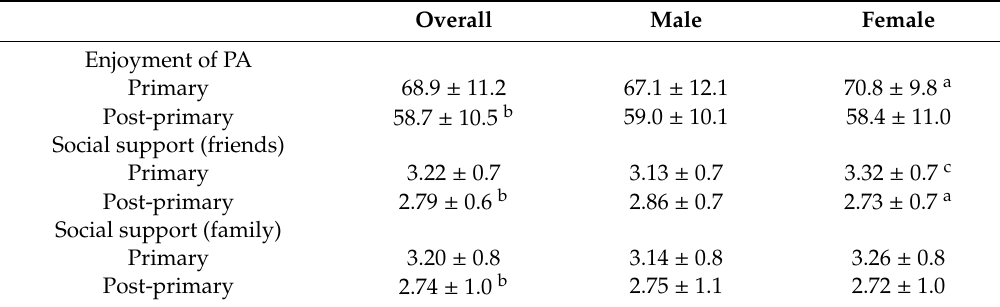
Table 3. Enjoyment and social support for physical activity.